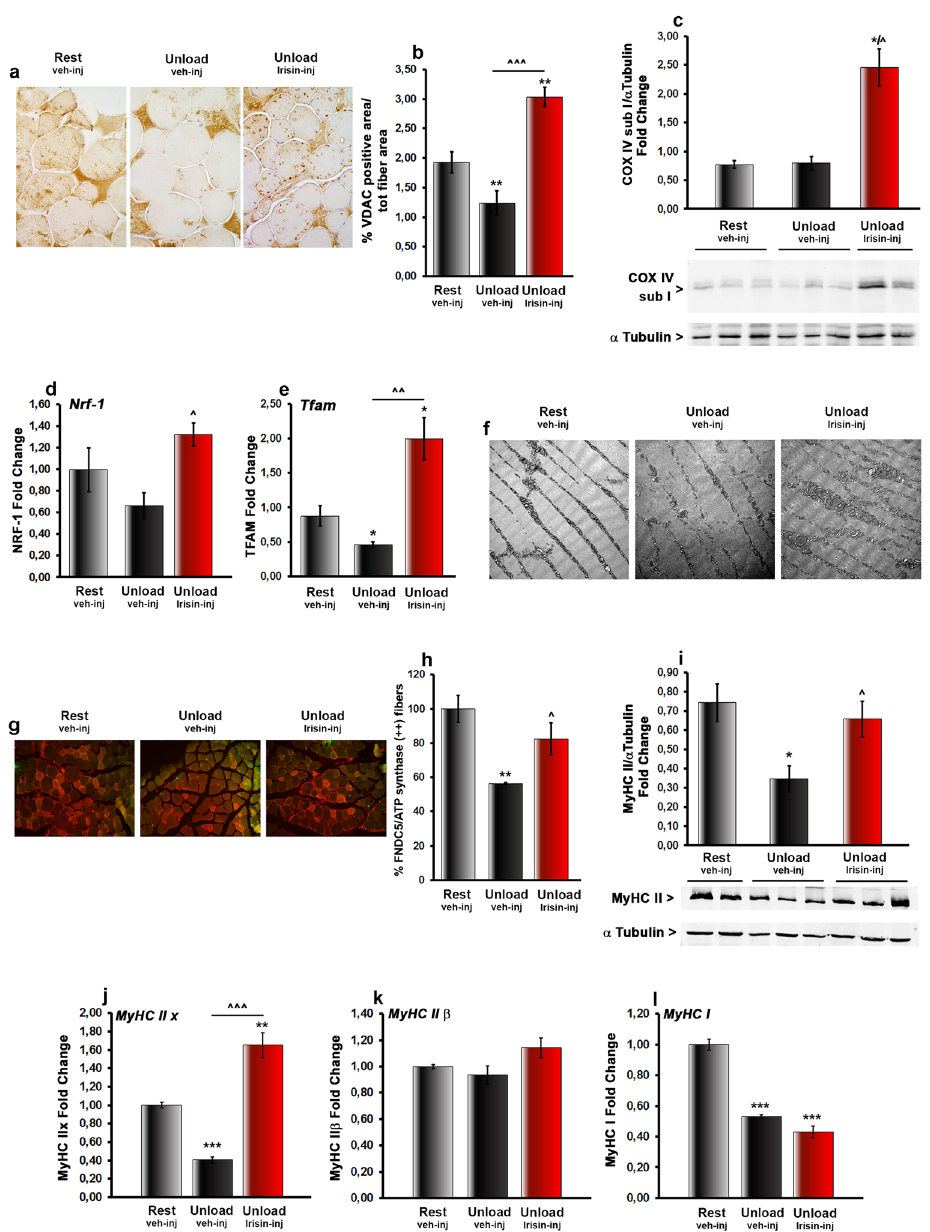
Figure 4. Treatment with r-Irisin inhibits myosin heavy chain type II decrease caused by unloading in vivo . ( a ) Representative images of immunohistochemistry staining of VDAC protein in vastus lateralis from normal loading mice (Rest vehicle-inj) and unloaded mice treated with vehicle or recombinant Irisin (r-Irisin, 100 µ g kg − 1 per week for 28 days, mice sacrificed 24 hours after last dose) (magnification: 40x). ( b ) Quantitative assessment of percentage of VDAC staining. ( c ) Densitometric quantitation of cytomchrome c oxidase subunit I (COX IV) expression versus control loading ( α -tubulin) in vastus lateralis isolated from Rest vehicle- injected and Unload vehicle- or r-Irisin-injected mice. ( d ) Nrf-1 and ( e ) Tfam mRNA expression (qPCR) in vastus lateralis harvested from Rest vehicle-injected and Unload vehicle- or Irisin-injected mice. ( f ) Electron microscope images. ( g ) Fluorescent micrographs of vastus lateralis sections of Rest vehicle-injected and Unload vehicle- or r-Irisin-injected mice immunolabeled for FNDC5 (green) and ATP synthase (red) (magnification: 20x). ( h ) Quantitative assessment of percentage of co-localization of FNDC5 and ATP synthase positive fibers ( i ) Densitometric quantitation of myosin heavy chain type II (MyHC II) expression versus control loading ( α -tubulin) in vastus lateralis isolated from Rest vehicle-injected and Unload vehicle- or r-Irisin-injected mice. ( j ) MyHC IIx , ( k ) MyHC II β and ( l ) MyHC I mRNA expression (qPCR) in vastus lateralis harvested from Rest vehicle-injected and Unload vehicle- or Irisin-injected mice. Data are presented as mean ± SEM. n = 3–4 mice per group. All data were normally distributed according to the Shapiro-Wilk normality test. Results from Fig. 4 were analyzed by one-way ANOVA and Bonferroni’s post hoc analysis. * p ≤ 0.05, ** p ≤ 0.01, *** p ≤ 0.001 versus Rest vehicle-injected mice. ^ p ≤ 0.05, ^^^ p ≤ 0.001 versus Unload vehicle-injected